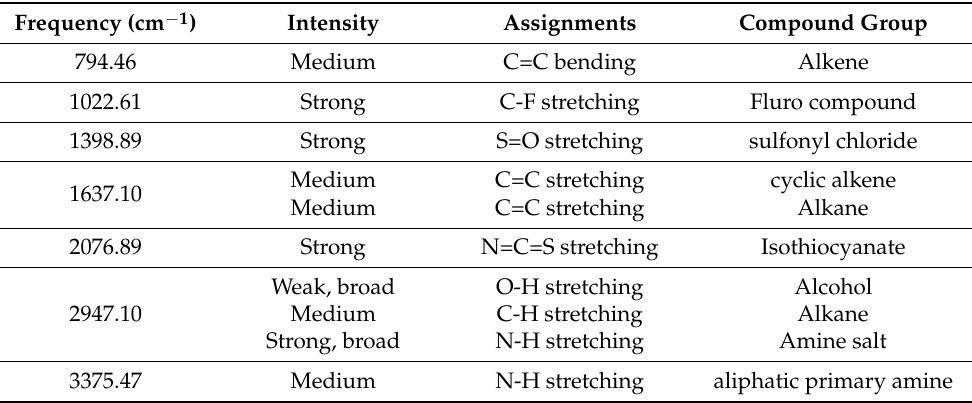
Table 4. Fourier Transform Infrared Spectrometer (FTIR) spectrum analysis for the methanolic extract of A. etbaica .